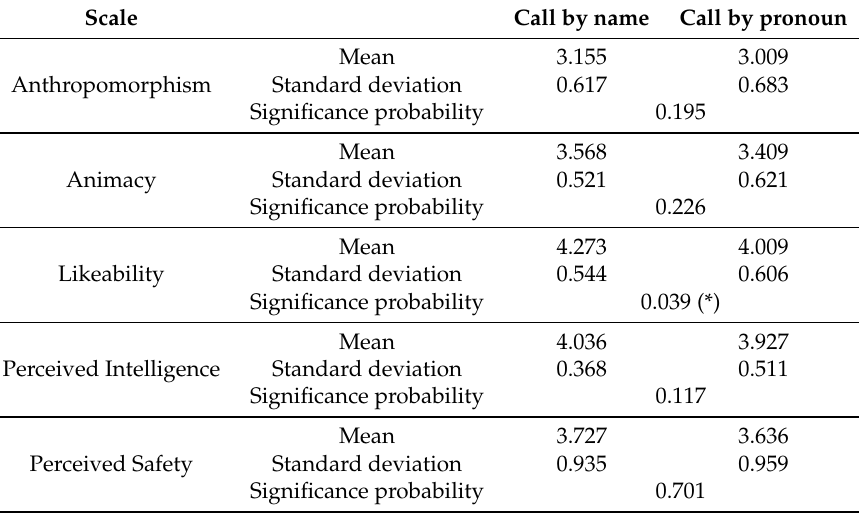
Table 6. Evaluation